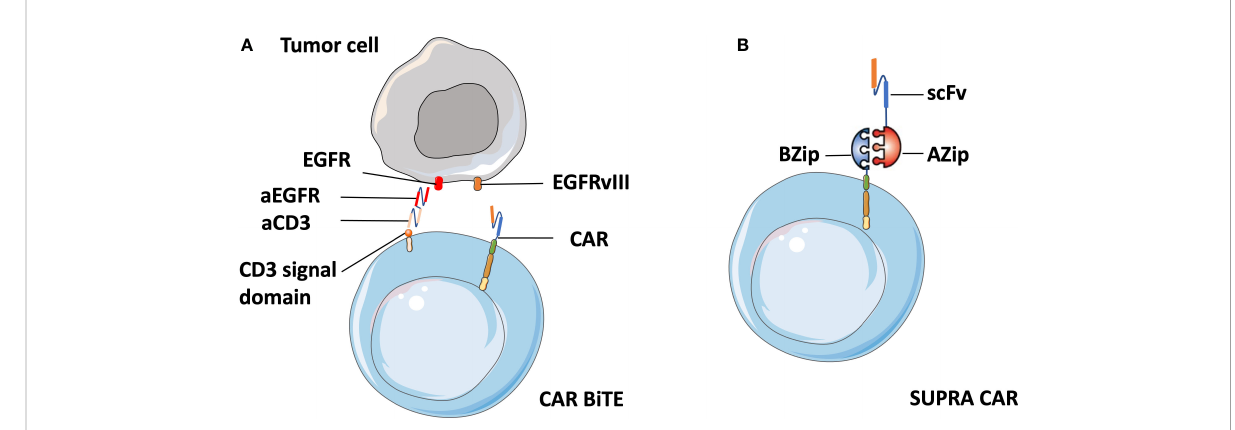
FIGURE 5 Schematic of CART.BiTE and SUPRA CAR. (A) Gene-modi fi ed EGFRvIII-CAR T cells deliver bispeci fi c antibodies known as BiTEs6 that are combined with antibody against wild-type EGFR (aEGFR) and antibody against the CD3 signal domain (aCD3). Therefore, CART.BiTE cells obtain the capacity to target EGFRvIII-negative tumor cells. (B) A SUPRA CAR system is composed of a zipCAR and zipFv. A leucine zipper (BZip) serves as the extracellular portion of the CAR. A cognate leucine zipper that can bind to the BZip links with the scFv